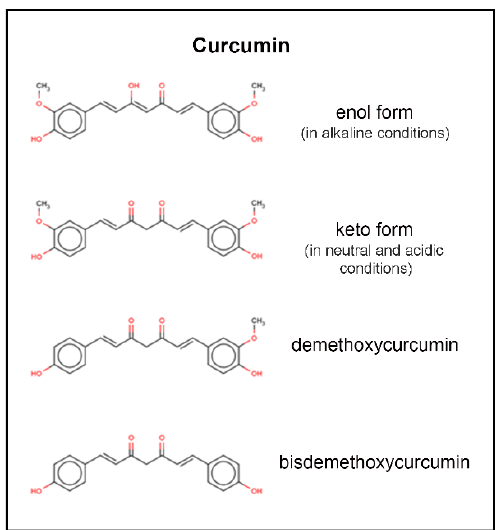
Figure 2. Molecular structure of curcumin and its tautomers. From top to bottom; curcumin in its enol form, curcumin in its keto form, demethoxycurcumin, and bisdemethoxycurcumin.